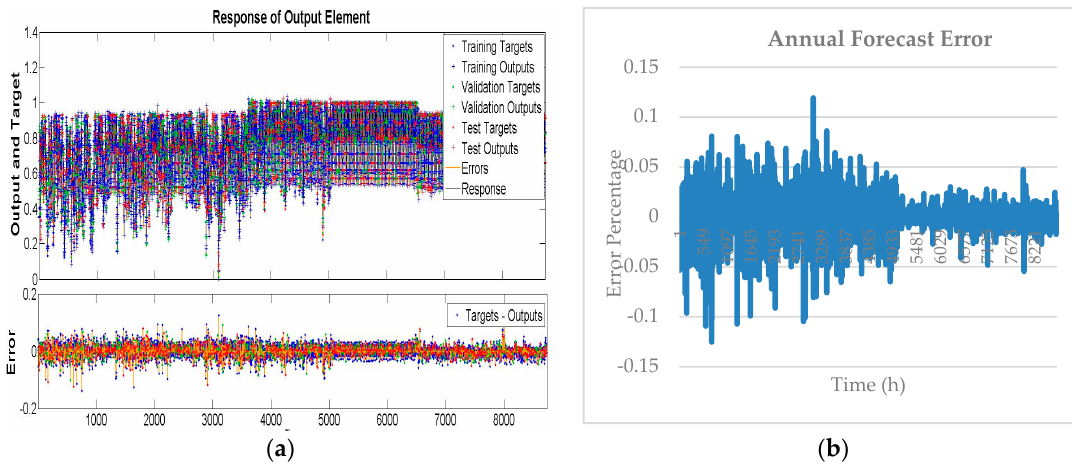
Figure 5. ( a ) Simulation result of NARX ‐ BPNN; ( b ) Annual forecast error of NARX ‐ BPNN.